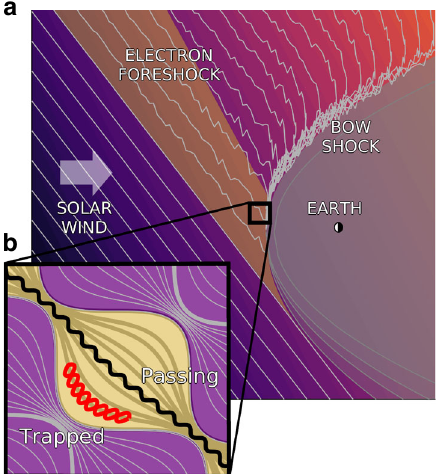
Fig. 1 Cartoon of fl ux tube with spatial variation. a Cartoon of the incoming solar wind, including the pre-bow shock magnetic fl uctuations, similar to the cartoon in Tsurutani and Rodriguez 34 . b The inset shows an example fl ux tube and a set of trapped (red) and passing (black) particle